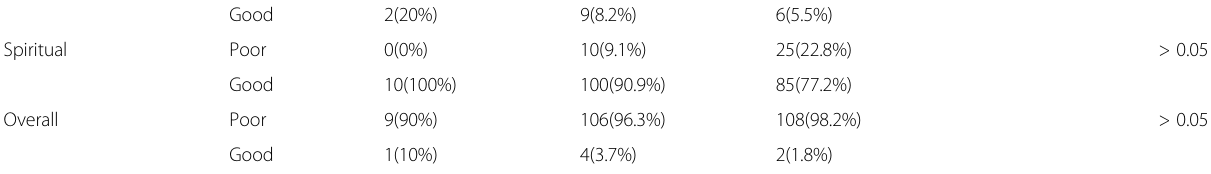
Table 1 Quality of life among PRTRs in relation to sex, marital status, and social class (Continued)